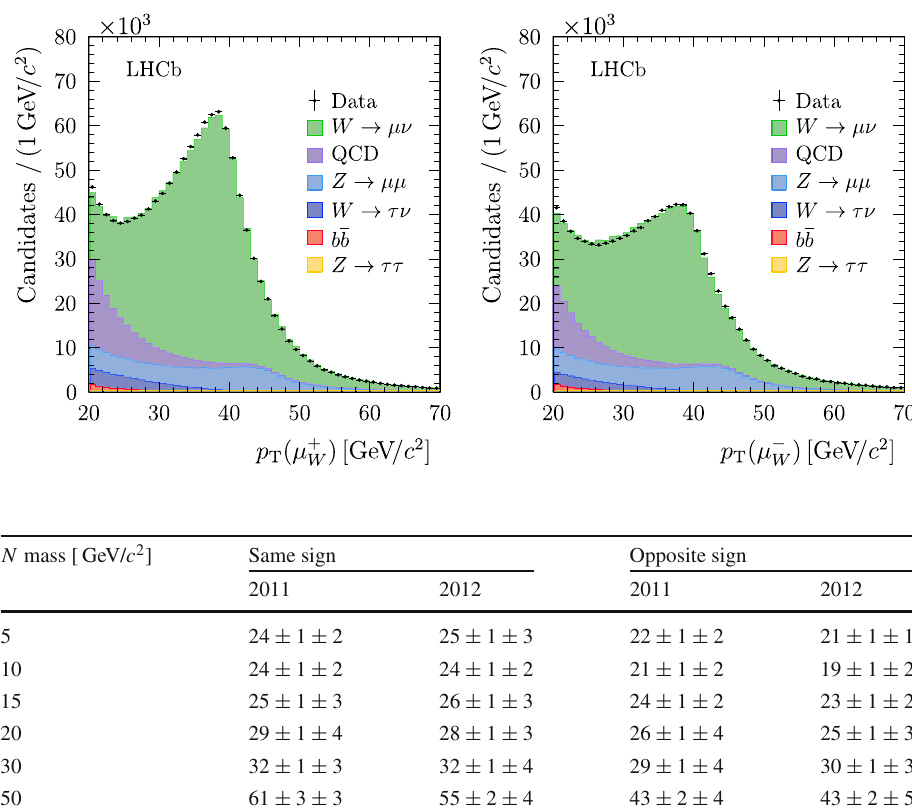
Fig. 3 The (left) positive and (right) negative muon transverse momentum spectra for the 2012 data set integrated over pseudorapidity for the normalisation channel. The filled histograms are the result of the fit to the data